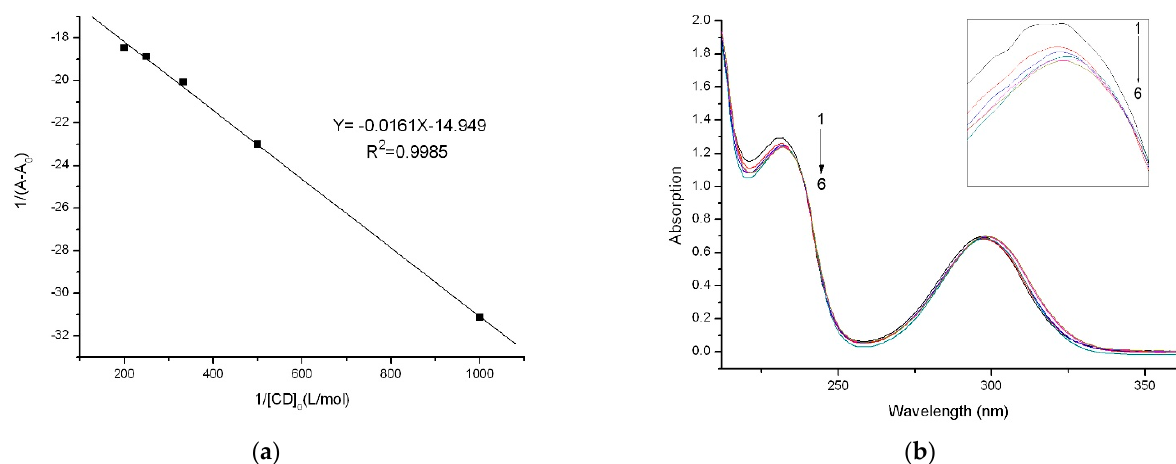
Figure 4. ( a ) The absorption spectra of 2.0 × 10 − 4 mol/L SA for different β - CD concentrations (×10 − 3 mol/L): (1) 0.0, (2) 1, (3) 2, (4) 3, (5) 4, and (6) 5, at 298 K; ( b ) Benesi–Hildebrand plot of 1/(A − A 0 ) vs. 1/[ β − CD] 0 for SA.